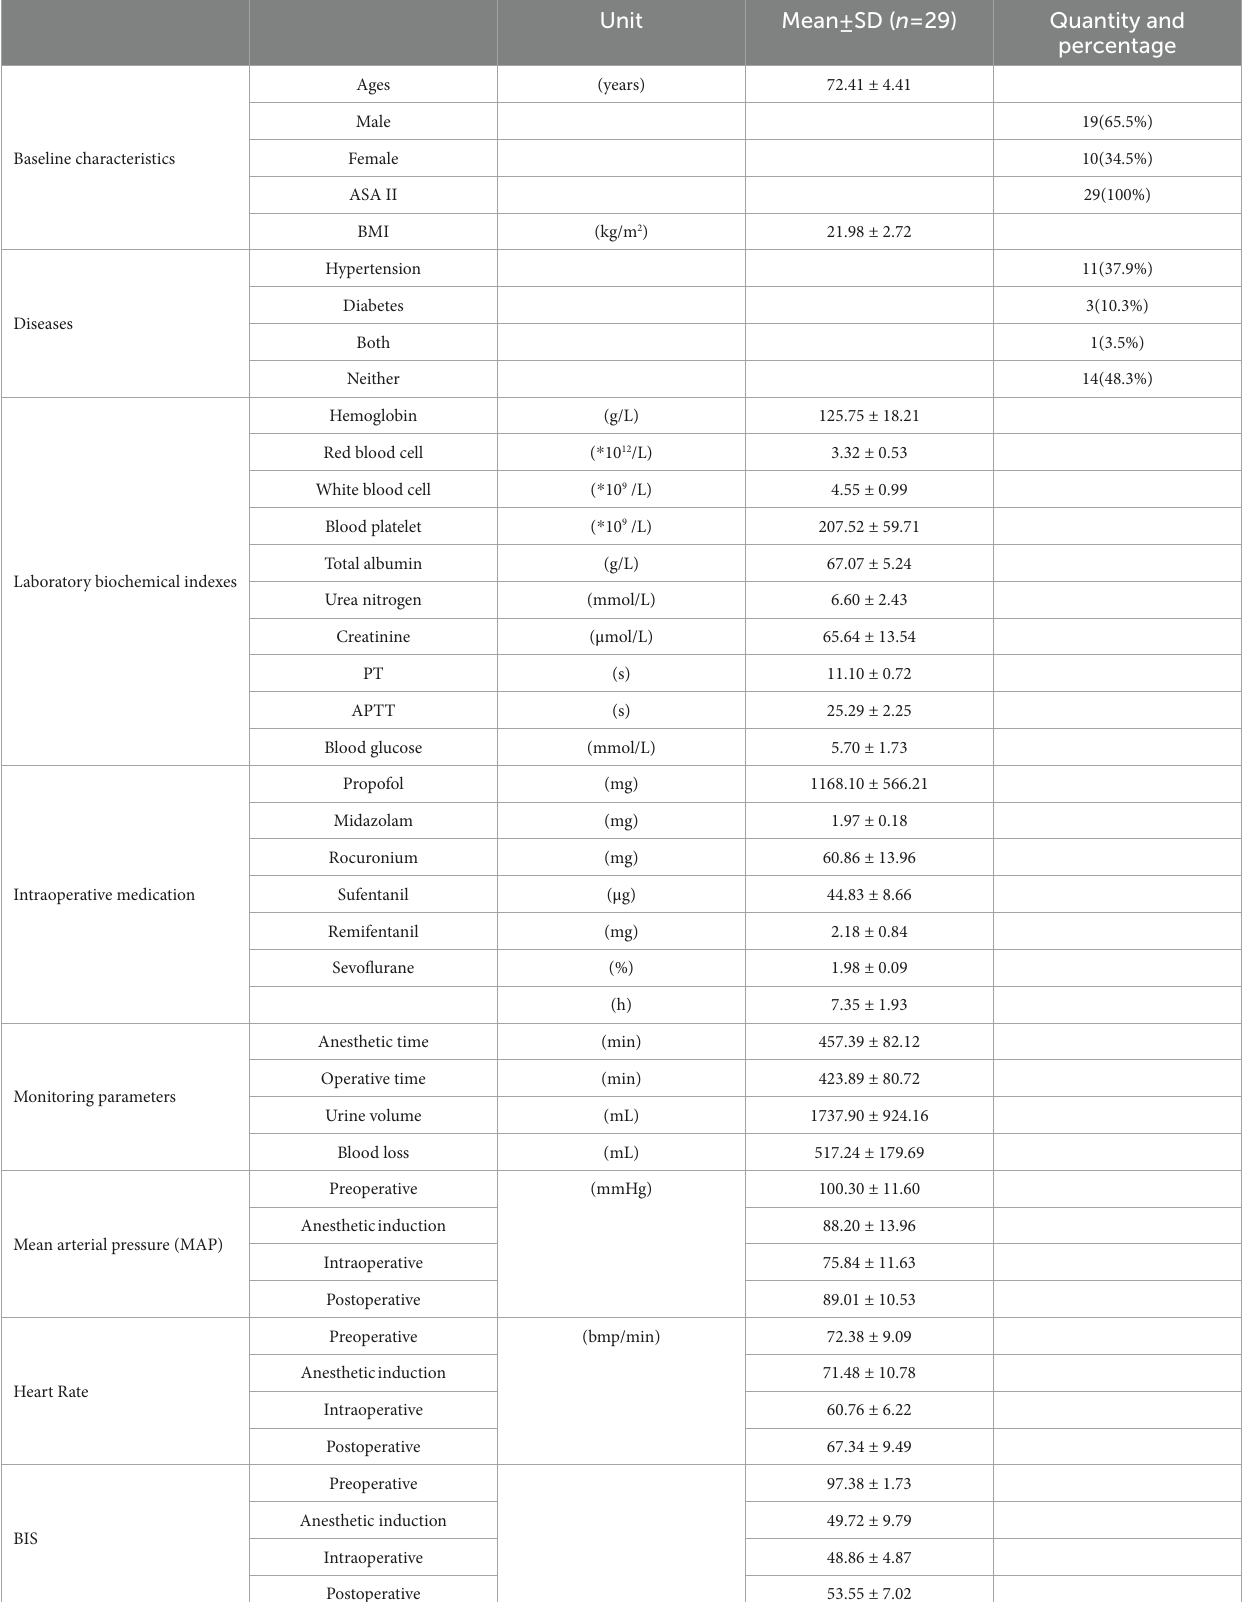
TABLE 1 The basic characteristics of the elderly patients included in the